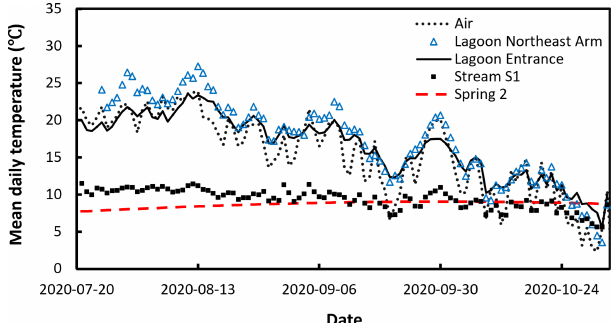
Figure 6. Illustrative examples (subset of monitored locations) of mean daily water temperatures vs. date (yyyy-mm-dd) for two lo- cations in the Basin Head lagoon (i.e., entrance and northeast arm), Stream S1, and Spring 2 (with tidal effects corrected by considering the temperature only at low tide; see Fig. 7), as well as mean daily air temperature over the final 4 months of the study period. The la- goon northeast arm water temperature series was calculated from the average of two paired sensors (one at the lagoon water surface and the other at the channel bottom; see Fig. 1). The raw, uncor- rected data and inferred annual groundwater temperature signal for Spring 2 are featured in Fig. 7c. Hourly data are in Fig. S9.